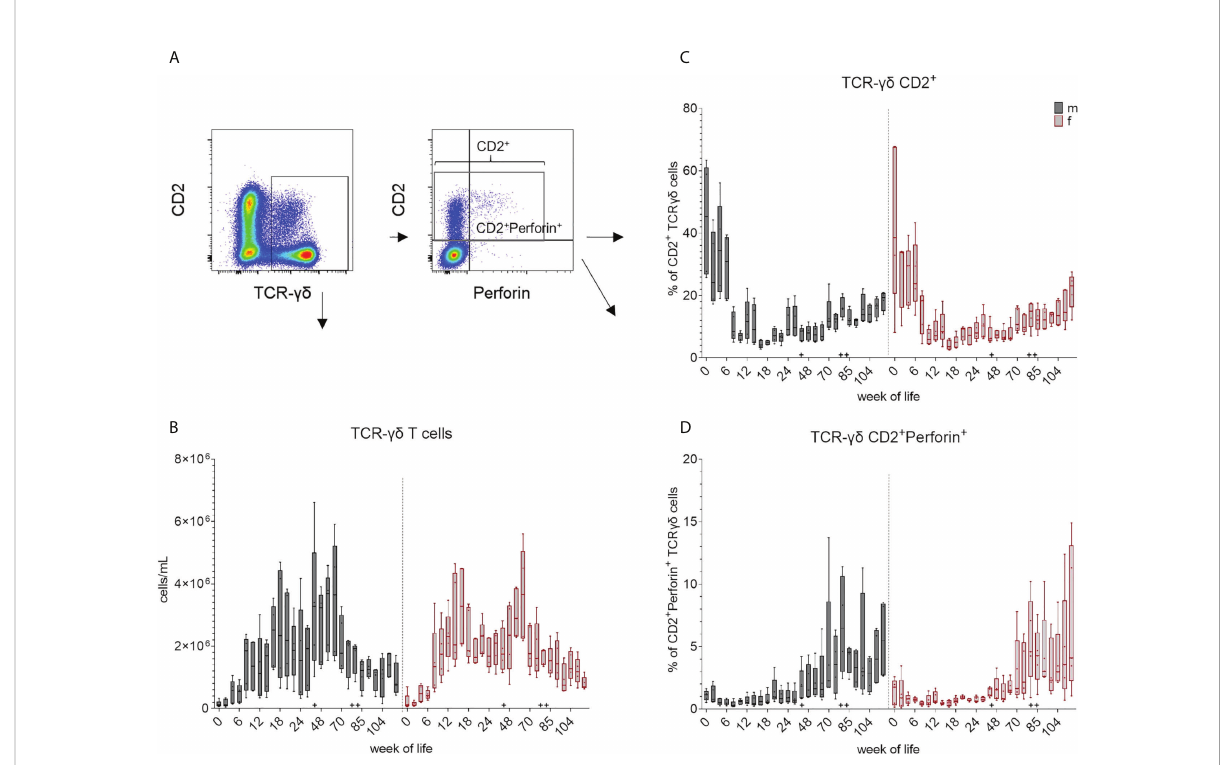
FIGURE 5 Total number of TCR- gd T cells and their differentiation over the study period. (A) shows the gating strategy for a representative EGM (male, 18 weeks of age) for the analysis of TCR- gd T cells. Staining of TCR- gd T cells for CD2 and perforin expression revealed three major subsets: CD2 - perforin - , CD2 + perforin - and CD2 + perforin + . (B) Frequencies obtained in FCM analyses were used for the calculation of the total number of TCR- gd T cells within the leukocyte population (TCR- gd T cells/mL) over a study period of 126 weeks. Graphs in (C) represent the percentage of CD2 + TCR- gd cells and (D) the relative increase of the CD2 + perforin + TCR- gd + T cell subset within the total TCR- gd T cells over a study period of 126 weeks. Sexes are represented by black (male) and red colors (female) in (B – D) . + marks the fi rst bleeding time point after transfer and vaccination, ++ marks the fi rst bleeding time point after booster